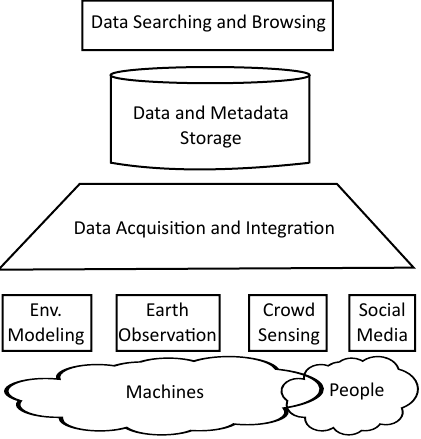
Figure 2. Main components of an environmental data